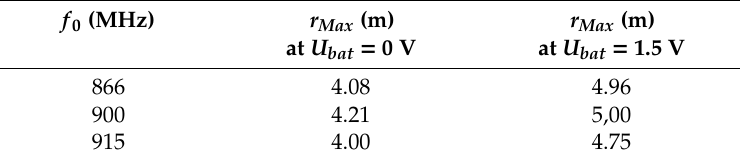
Table 6. Examples of research results: read range vs. frequency and U bat